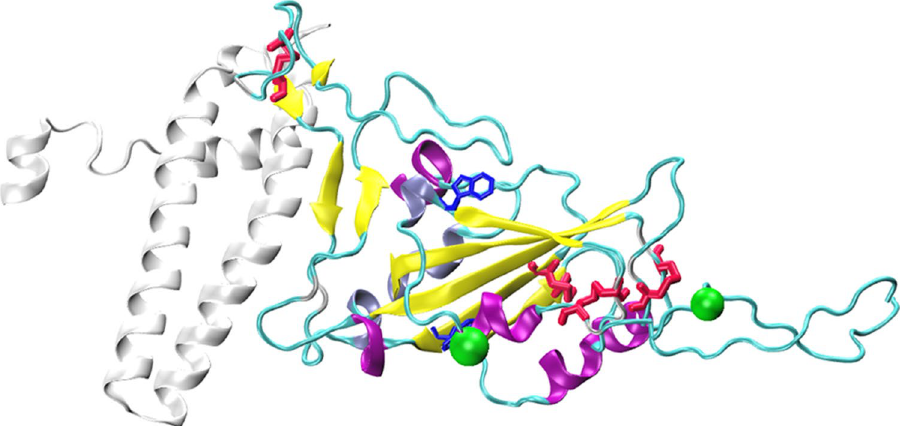
Figure 1. Structure of SARS-CoV-2 Receptor Binding Domain bound to ACE2. The secondary structure elements of RBD are differentially colored (Alpha helices: purple, 3_10 helices: iceblue, beta strands: yellow, and turns/coil: cyan). Disulfide bridges (red) and tryptophan residues (blue) are shown as sticks, while N -glycosylation asparagine residues (green) are shown as VDW spheres. The region of ACE2 encompassing residues 1–115 (colored white) which interacts with RBD is also shown. The structure was generated using Protein Data Bank (PDB) structures 6xm0 and